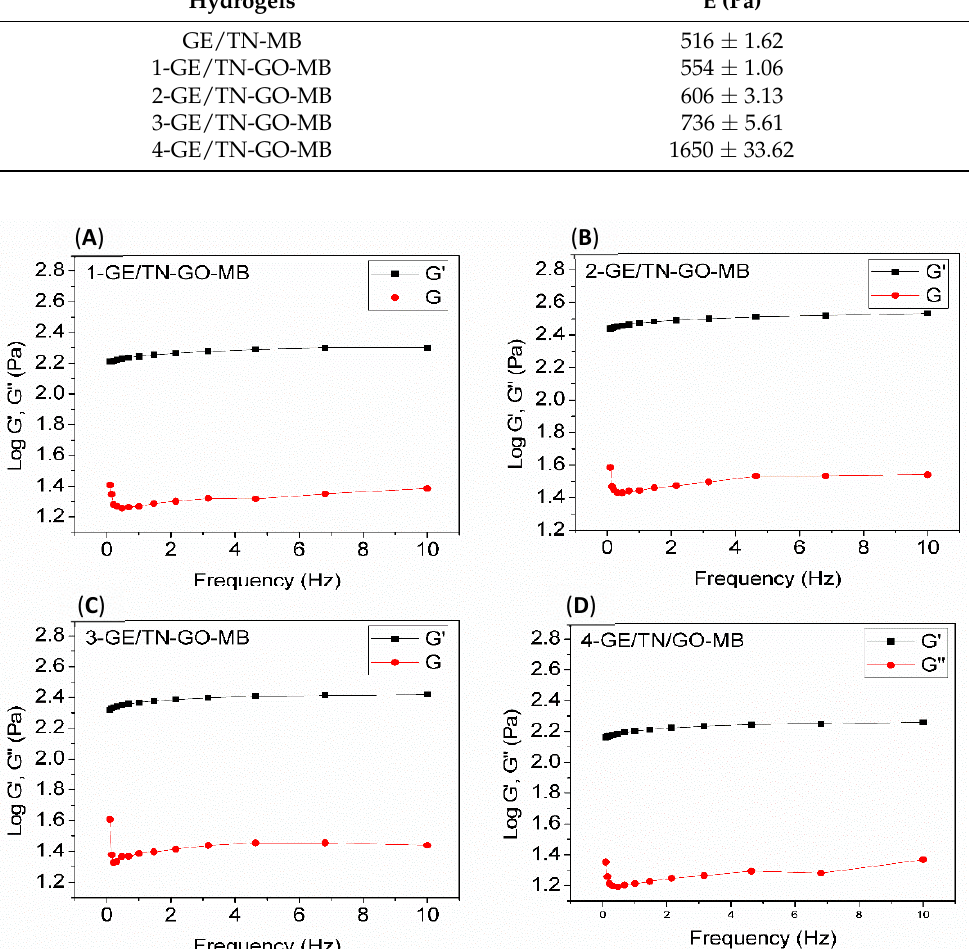
Figure 3. G’ and G” as a function of the oscillatory frequency for GE/TN-GO-MB systems with Figure 3. G’ and G’’ as a function of the oscillatory frequency for GE/TN-GO-MB systems with different GO content (Table 1) at 37 ◦ C. ( A ) 1-GE/TN-GO-MB; ( B ) 2-GE/TN-GO-MB; ( C ) 3-GE/TN- different GO content (Table 1) at 37 °C. ( A ) 1-GE/TN-GO-MB; ( B ) 2-GE/TN-GO-MB; ( C ) 3-GE/TN- GO-MB; and ( D ) GO-MB; and ( D ) 4-GE/TN-GO-MB.